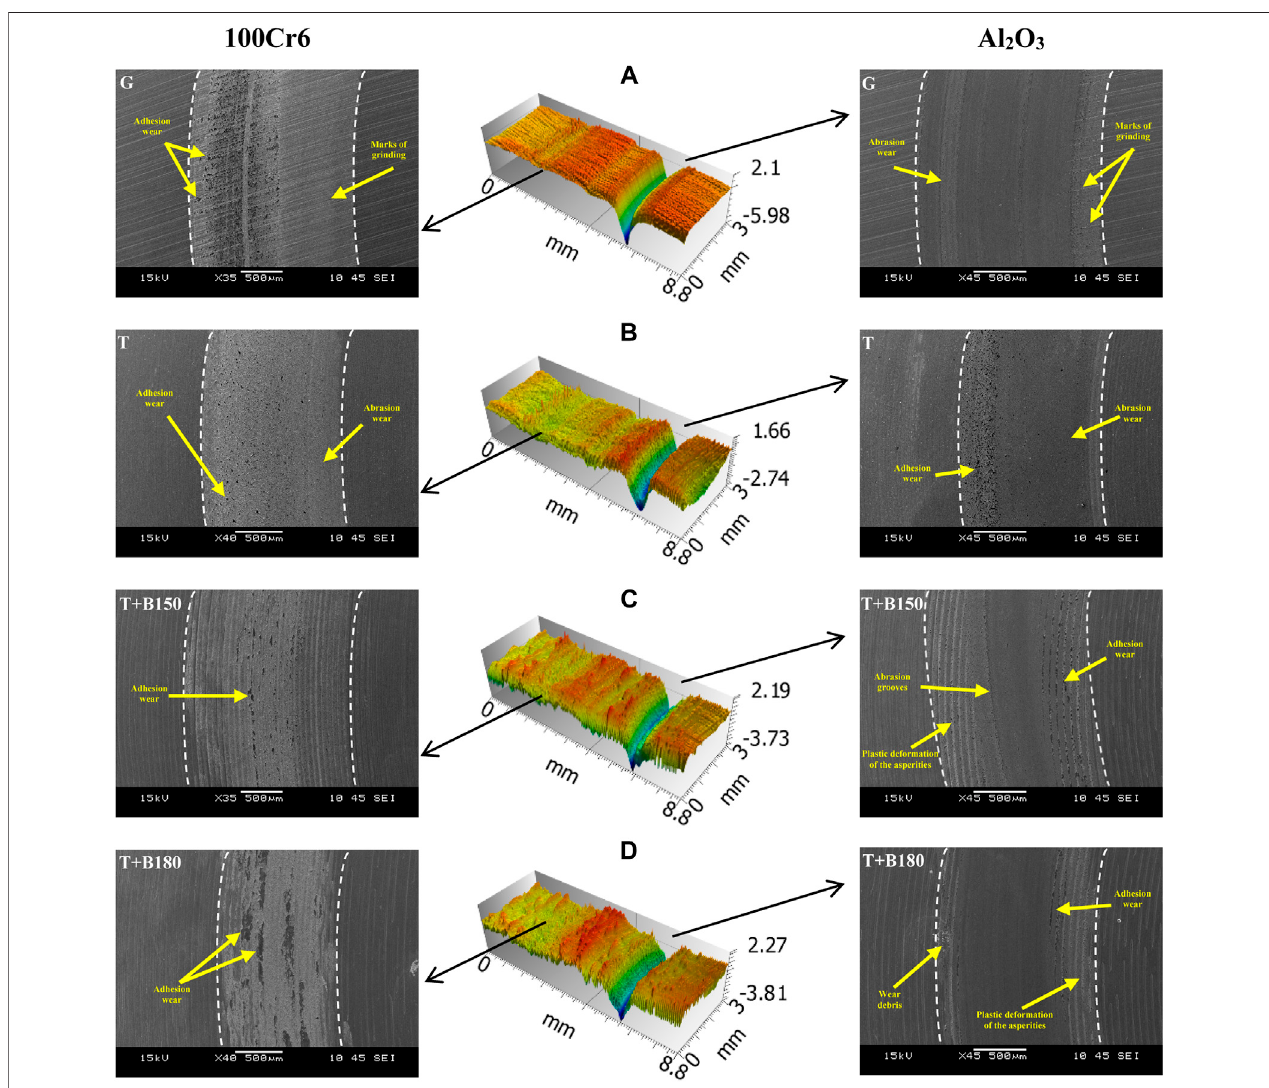
FIGURE 11 | Examples of the pro fi lograph running s across the track following the wear as well as images of wear (after ball-on-disc test) for Vanadis 8 tool steel after different surface treatments: (A) G, (B) T, (C) T + B150, (D) T + B180.